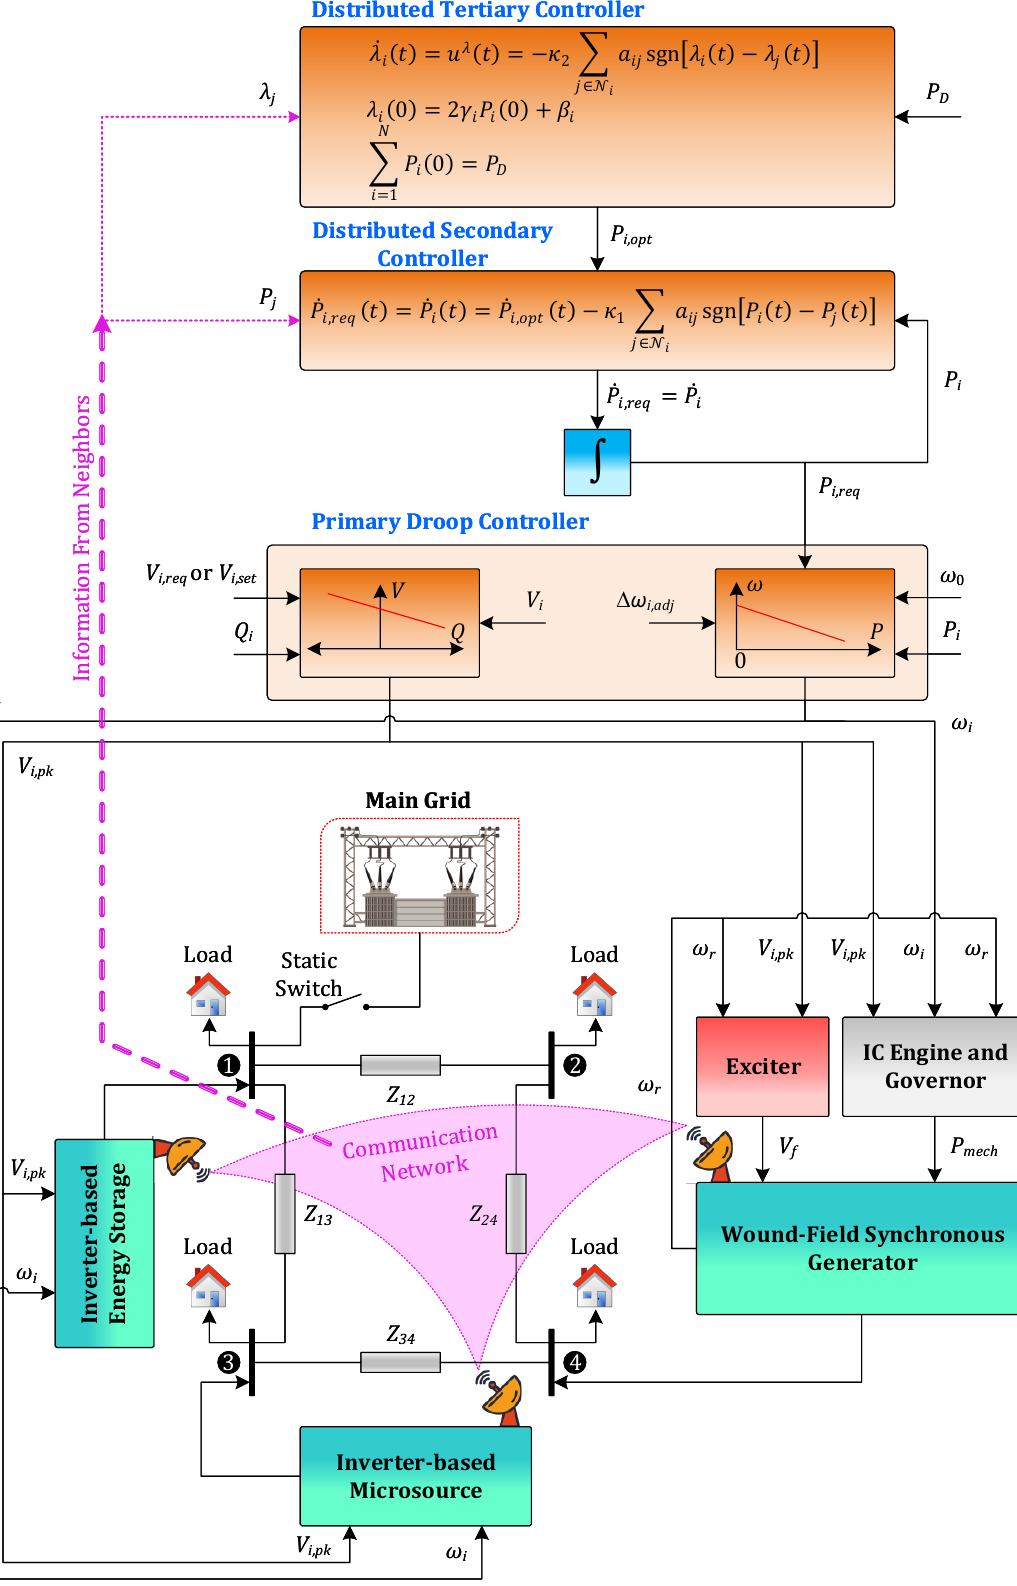
Figure 2. Overall closed-loop implementation of the proposed distributed hierarchical control